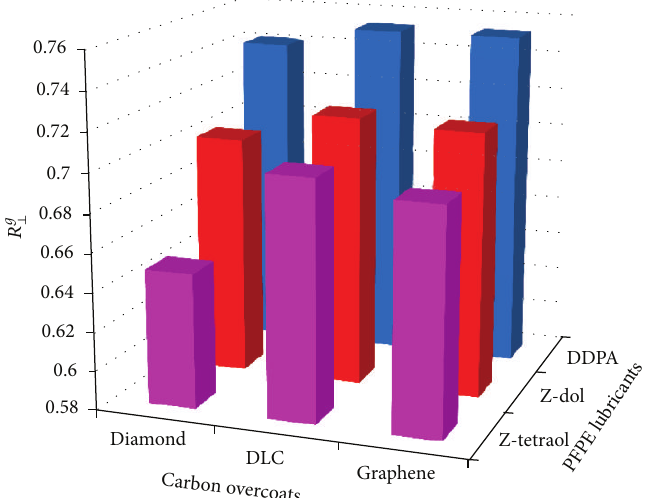
Figure 25: The perpendicular component of radii of gyration ( 𝑅 ⊥ [𝜎] ) for each component of the material matrix.